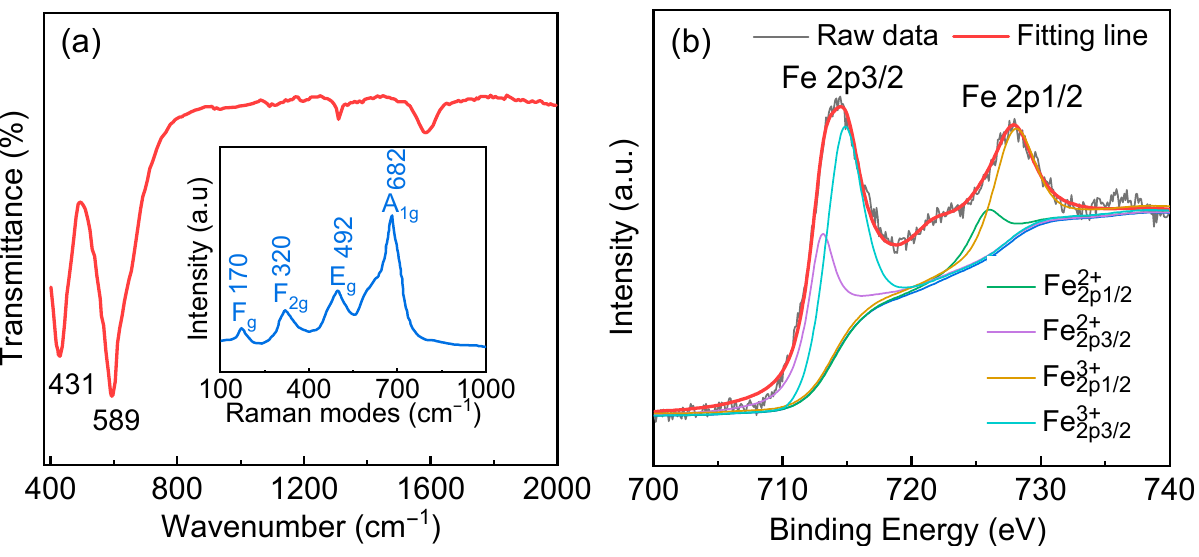
Figure 3. ( a ) Room-temperature FTIR spectrum and Raman spectra of the Pr 2 FeAlO 6 ceramic sample; ( b ) X-ray photoemission experiment performed at room temperature for Pr 2 FeAlO 6 .